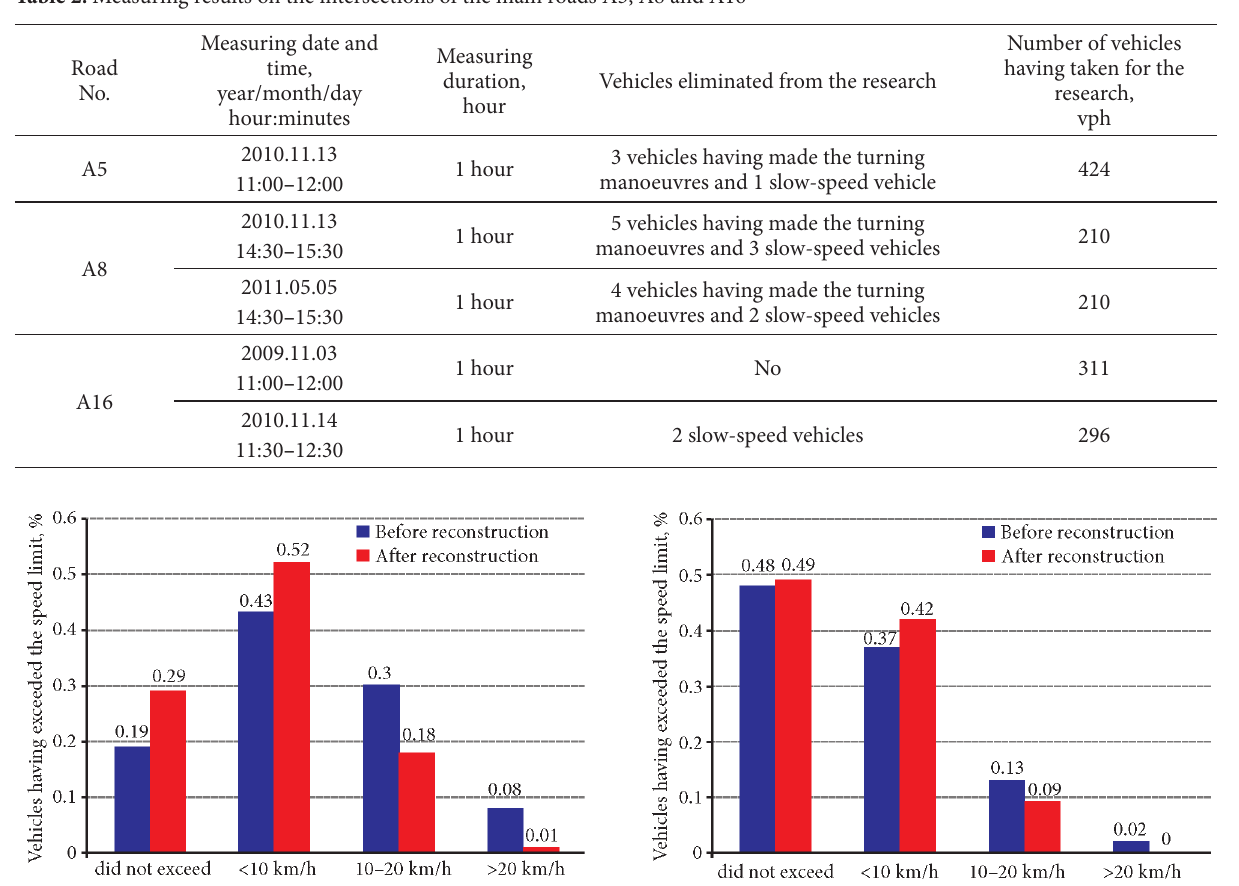
Number of vehicles having taken for the